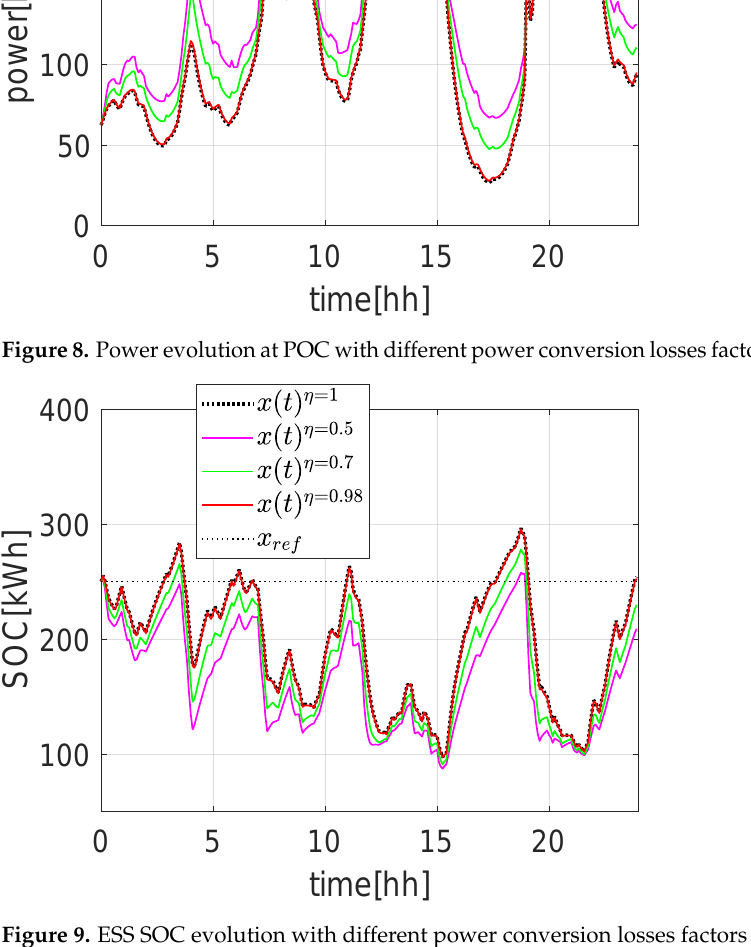
Figure 9. ESS SOC evolution with different power conversion losses factors η ∈ { 0.5,0.7,0.98,1 }